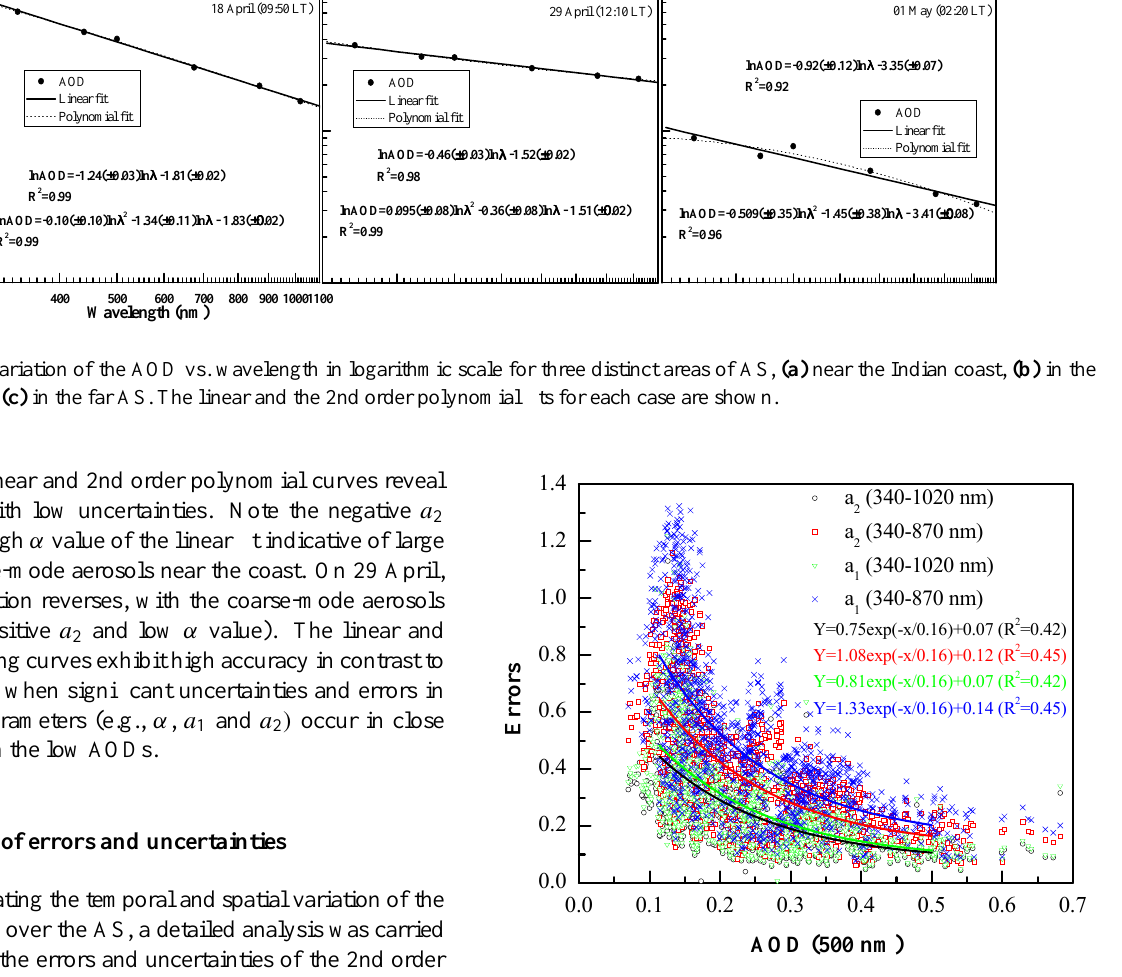
Fig. 3. Correlation of the errors in a 1 and a 2 obtained from the polynomial fit of the ln τ λ vs. ln λ in the two spectral bands with the AOD 500